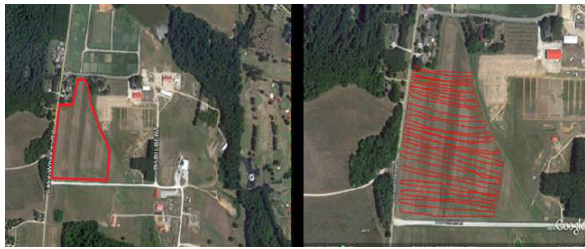
Figure 1. Figure placement and numbering 2.2 Data Bare earth lidar data of our study site is provided by North Carolina Foodplain Mapping program(www.ncfloodmaps.com). The horizontal coordinate system of this point cloud is NAD 1983 State Plane North Carolina and its unit is in feet scale. The vertical coordinate system of point cloud is NAVD88 (North American Vertical Datum 88) and its unit is again in feet scale. GPS data in study site are gathered by Nokia N900’s GPS deriver. GPS data’s horizontal and vertical coordinate systems are WGS84. Its horizontal coordinate units are in decimal values of latitude and longitude and the vertical unit is in meter scale.